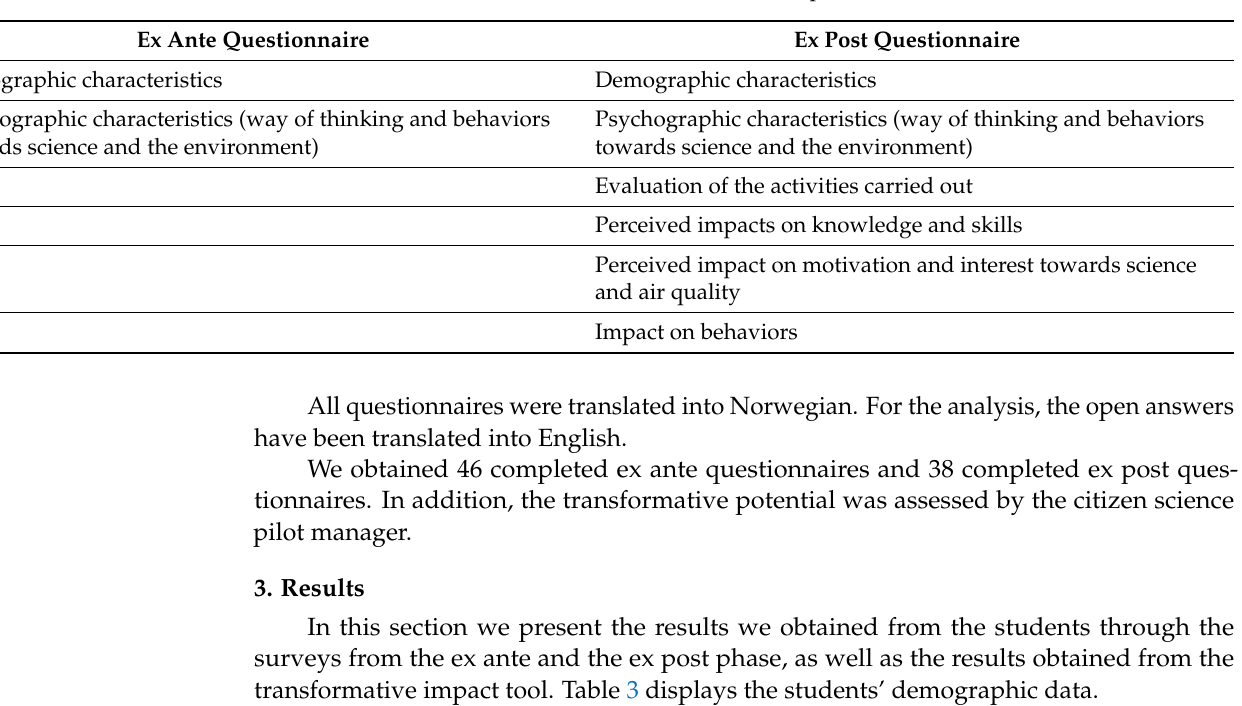
Table 2. Data collected for students, ex ante and ex post.